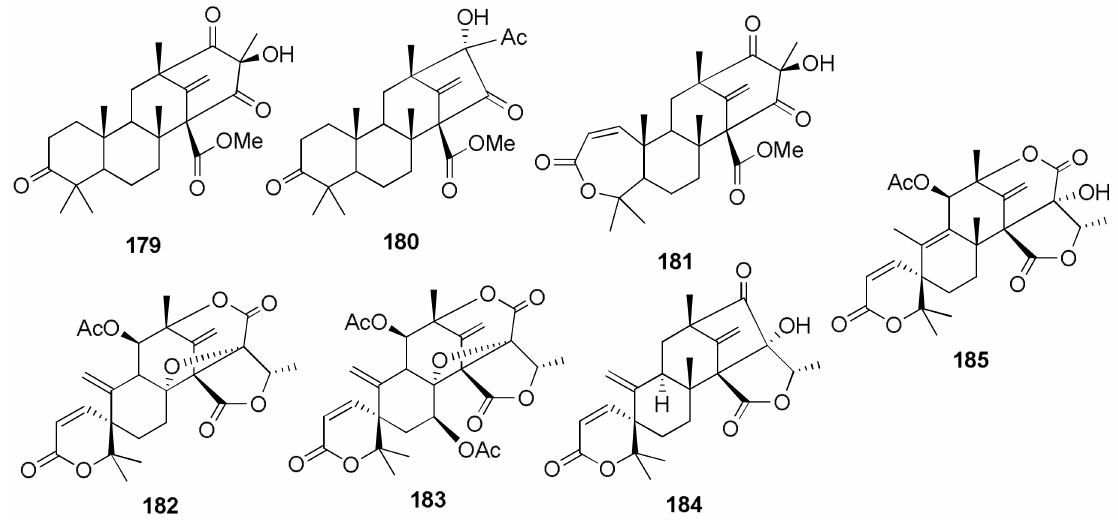
Figure 12. The structures of preaustinoid A ( 179 ), preaustinoid B ( 180 ), preaustinoid A2 ( 181 ), dehydroaustin ( 182 ), acetoxydehydroaustin ( 183 ), neoaustin ( 184 ), and austin ( 185